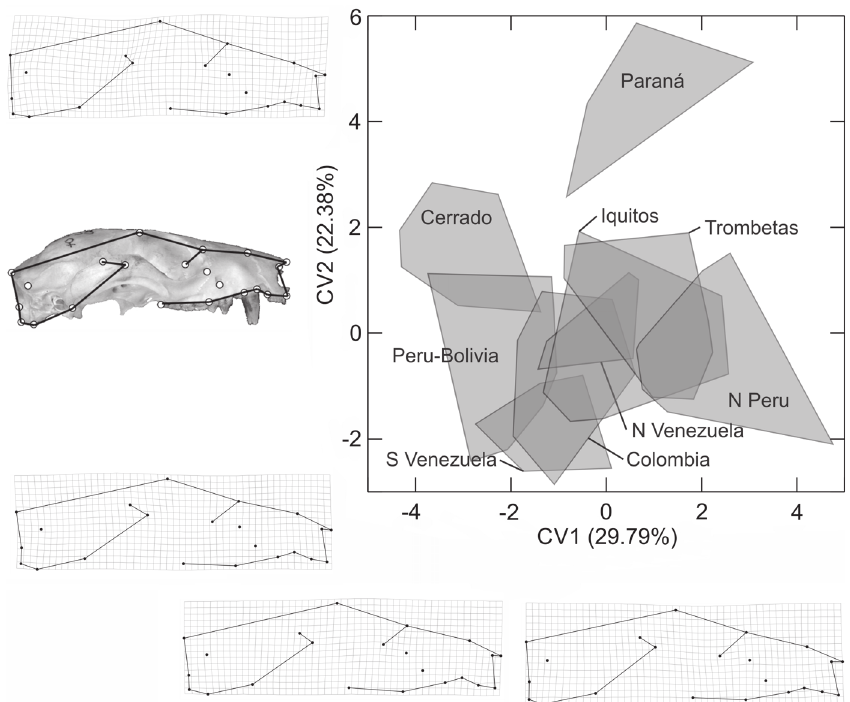
Figure 7. Canonical Variates Analysis on shape variables (partial warps and uniform components) of the cranium in lateral view of Caluromys lanatus , using localities as grouping factors, and percentage of variance explained by the first two CVs. Only the convex hulls for each population are shown. Grids indicate deformation associated with the extremes of each CV, from a multivariate regression of shape variables onto CV